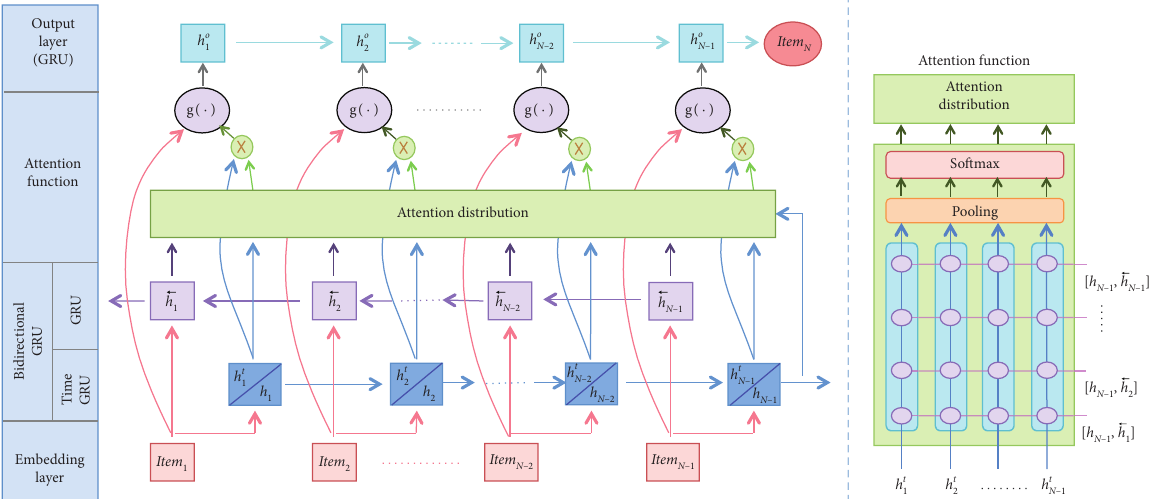
Figure 2: The proposed framework for modeling sequential user behaviors (left) and the designed attention mechanism